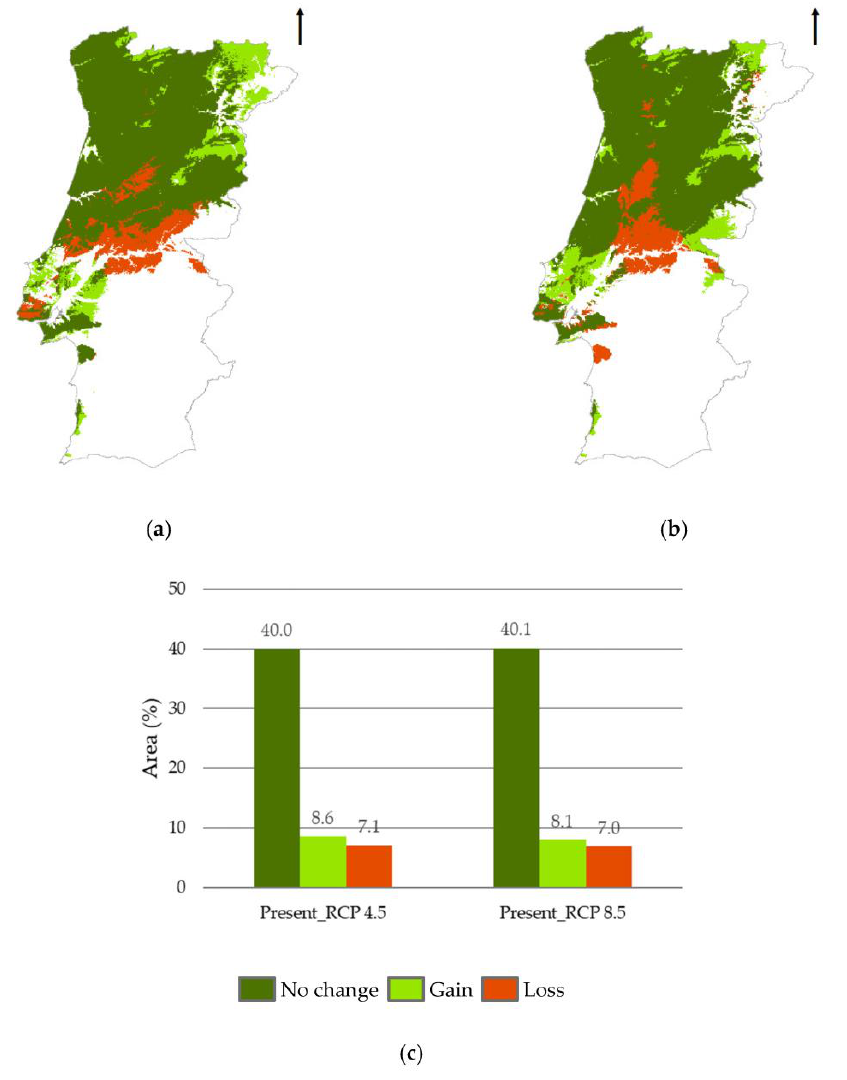
Figure 7. MaxEnt — Maritime pine distribution area changes under the climate change scenarios: ( a ) Present to future 2070 under RCP 4.5 climate change scenario; ( b ) Present to future 2070 under RCP 8.5 climate change scenario; and ( c ) No change, gains, and losses areas (%) between present and future.